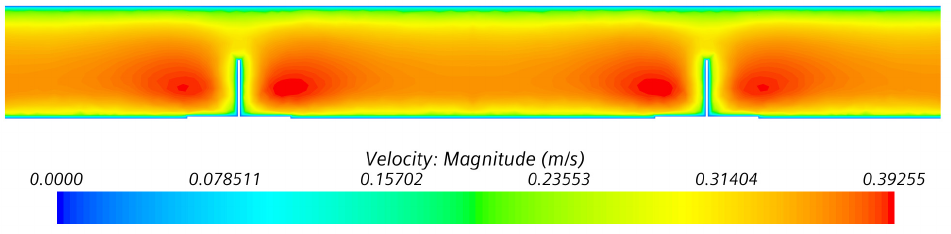
Figure 16. Velocity field—horizontal cross section at height of 10 m winter extreme.